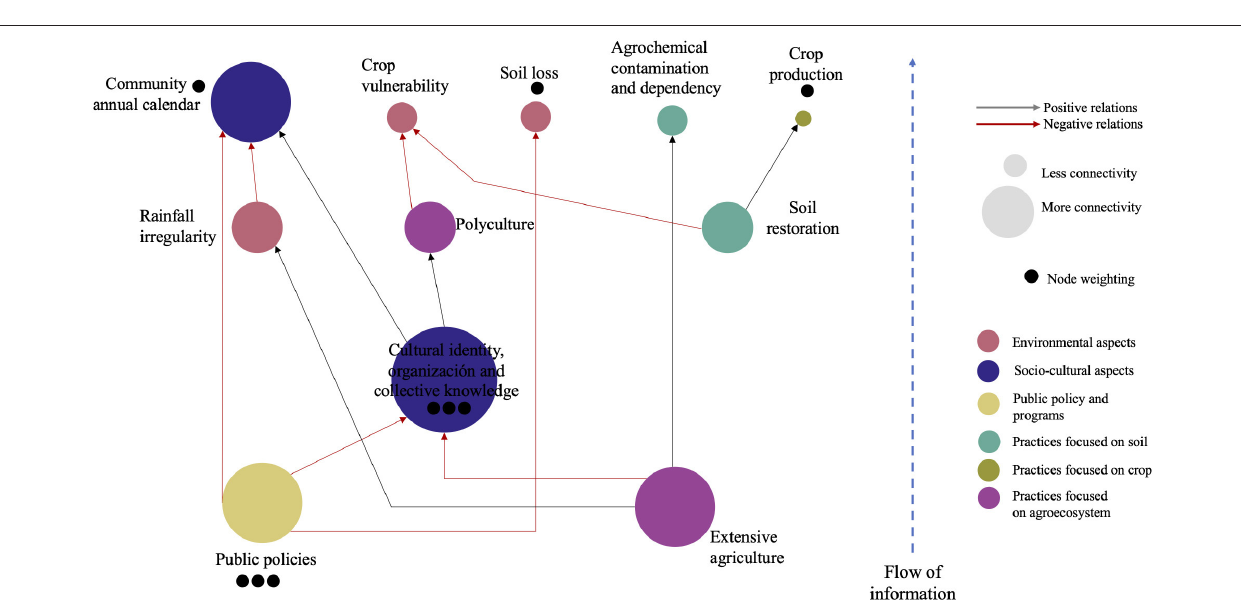
FIGURE 7 | Top eleven nodes for the CSO CM based on centrality measures. Size of the nodes correspond to connectivity. Black dots represent the weighting